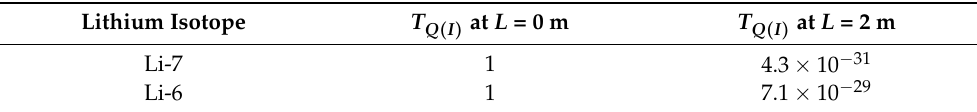
from the value at L = 0 m to the value at L = 2 m according to the setting values in graph (b) of Figure